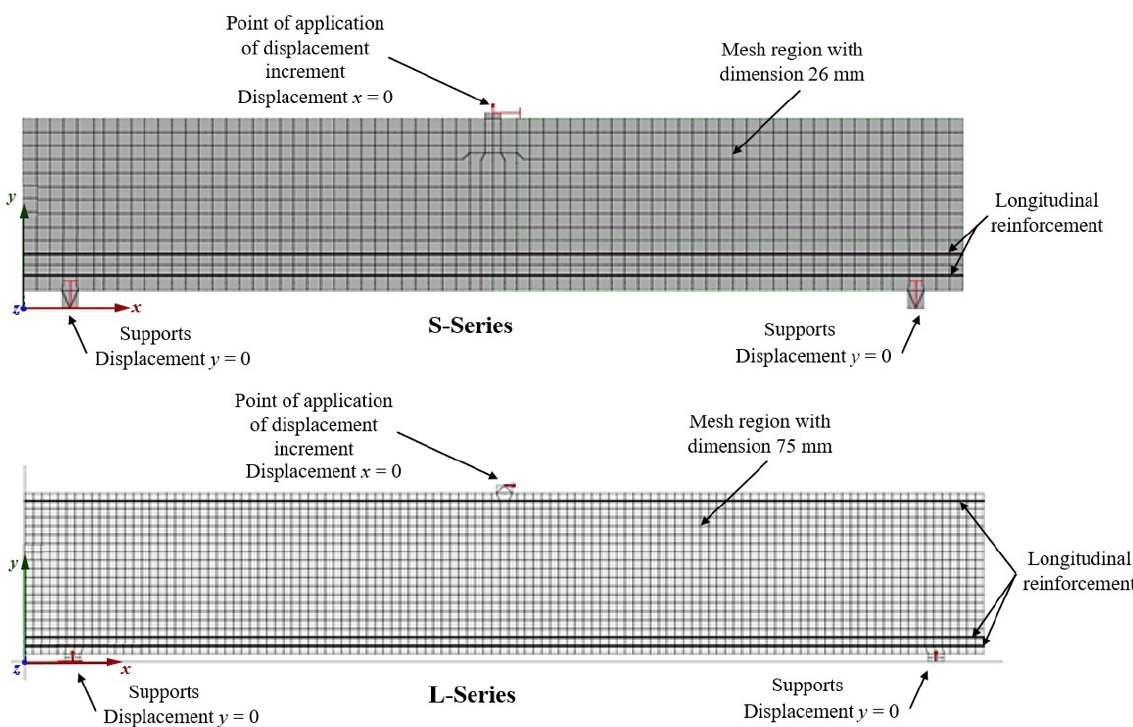
Figure 3. S and L series beams numerical